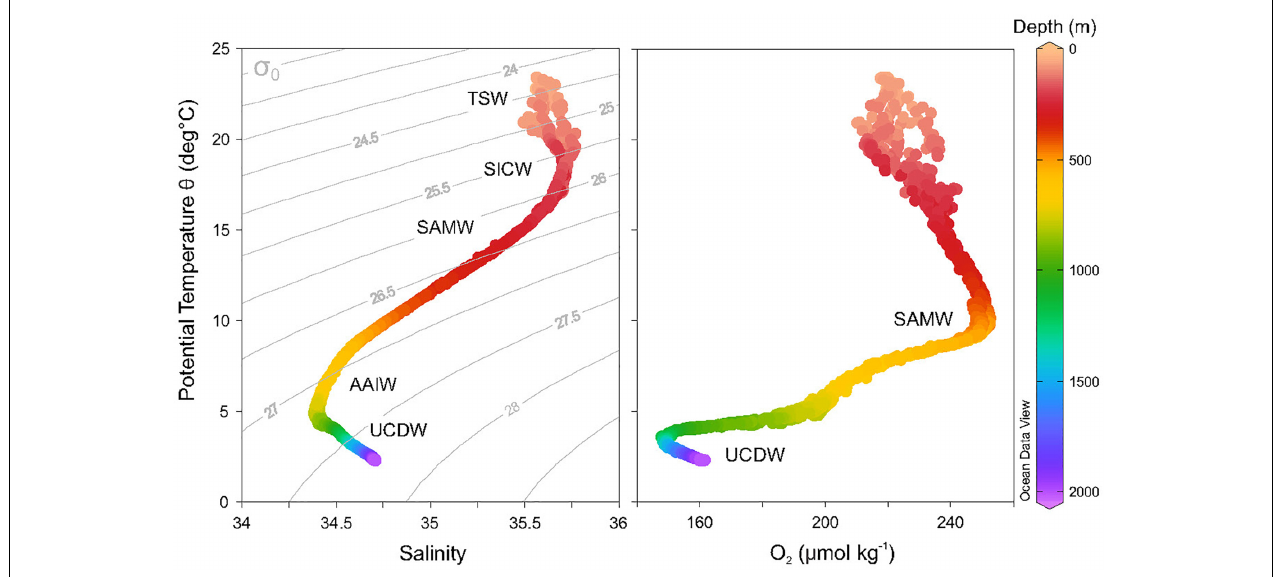
FIGURE 5 | Temperature–salinity (left) and temperature–oxygen (right) plots for Potential Temperature Depth of Perth Canyon waters with water masses indicated. TSW, Tropical Surface Water; SICW, Subtropical Indian Central Water; SAMW, Subantarctic Mode Water; AAIW, Antarctic Intermediate Water; UCDW, Upper Circumpolar Deep Water. Isopycnals calculated with the reference pressure at 0